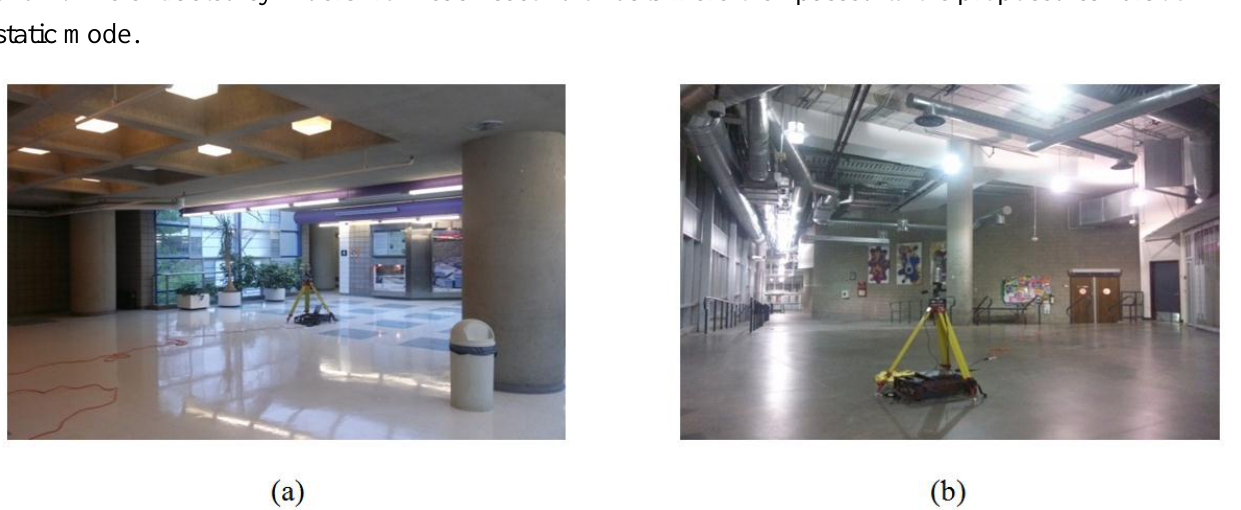
Figure 10. Two scenes contain vertical pillars at University of Calgary campus, Canada ( a ) for Dataset 1 ( b ) for Dataset